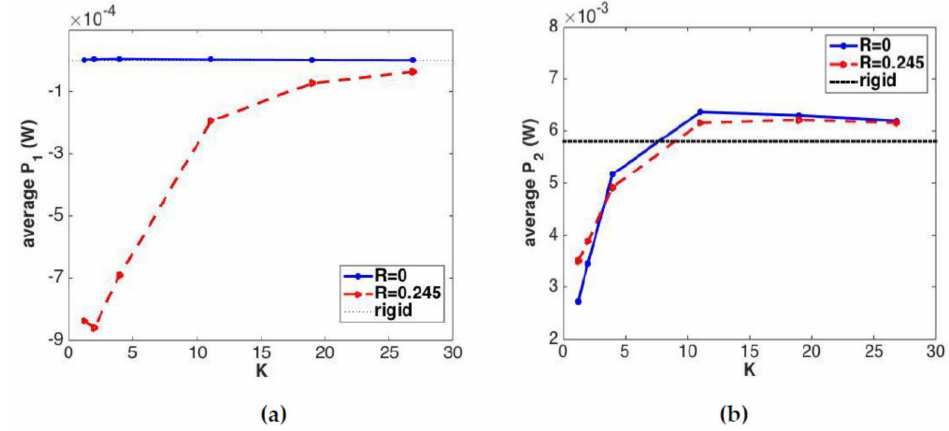
Figure 13. Average power at ( a ) passive joint and ( b ) active